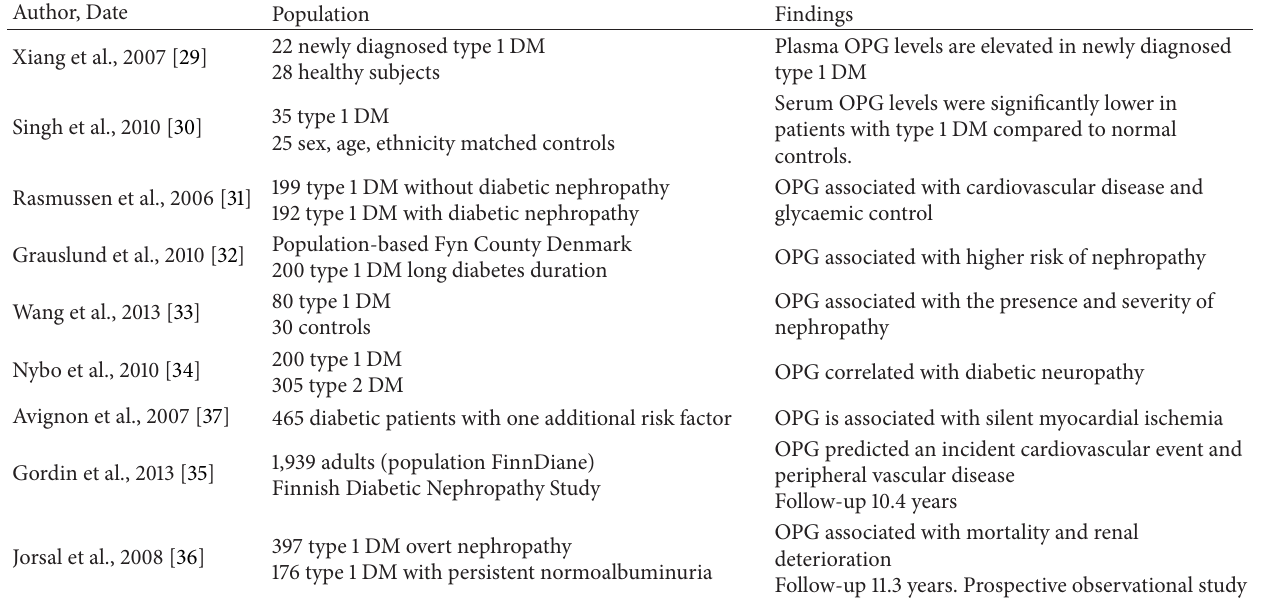
Table 2: Studies assessing the association between osteoprotegerin and diabetes mellitus type